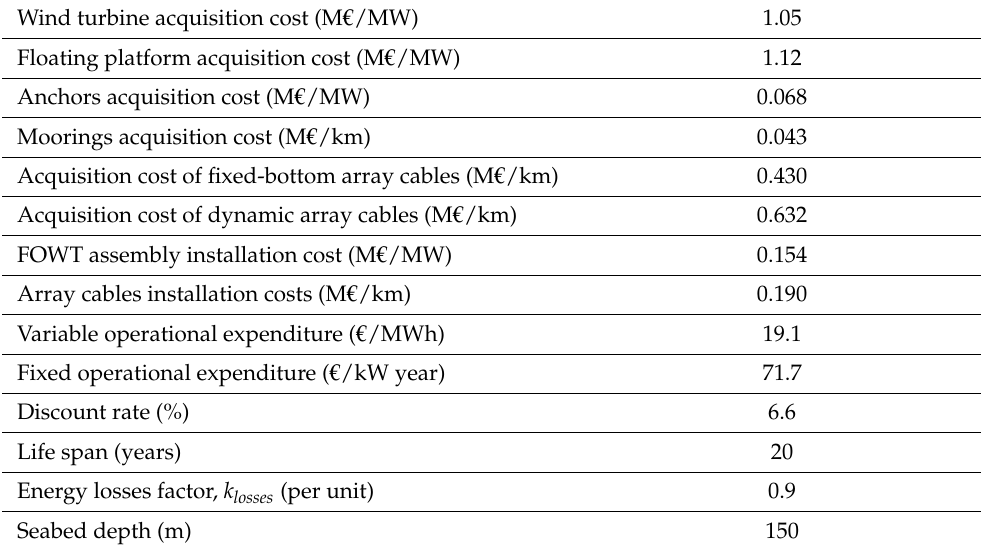
Table 2. Techno-economic data used in the test